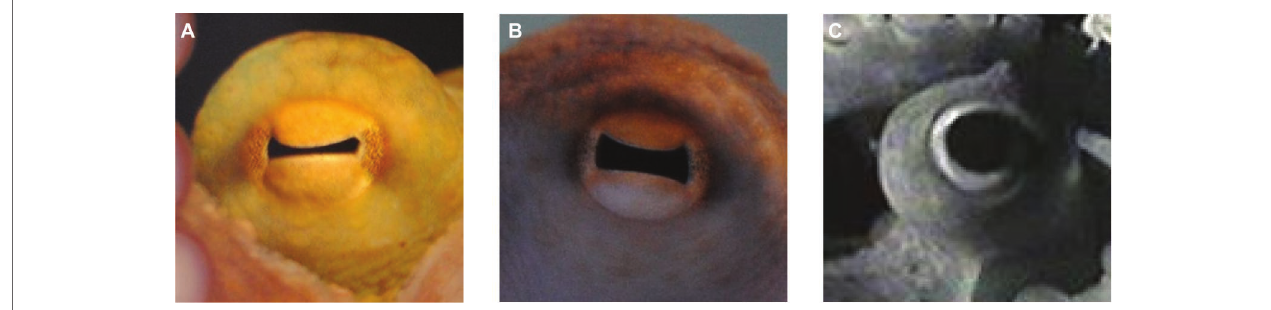
FIGURE 1 | Pupil of Octopus vulgaris . (A) Constricted horizontal slit pupil in bright light, (B) intermediate pupil size, and (C) fully dilated pupil in dim light